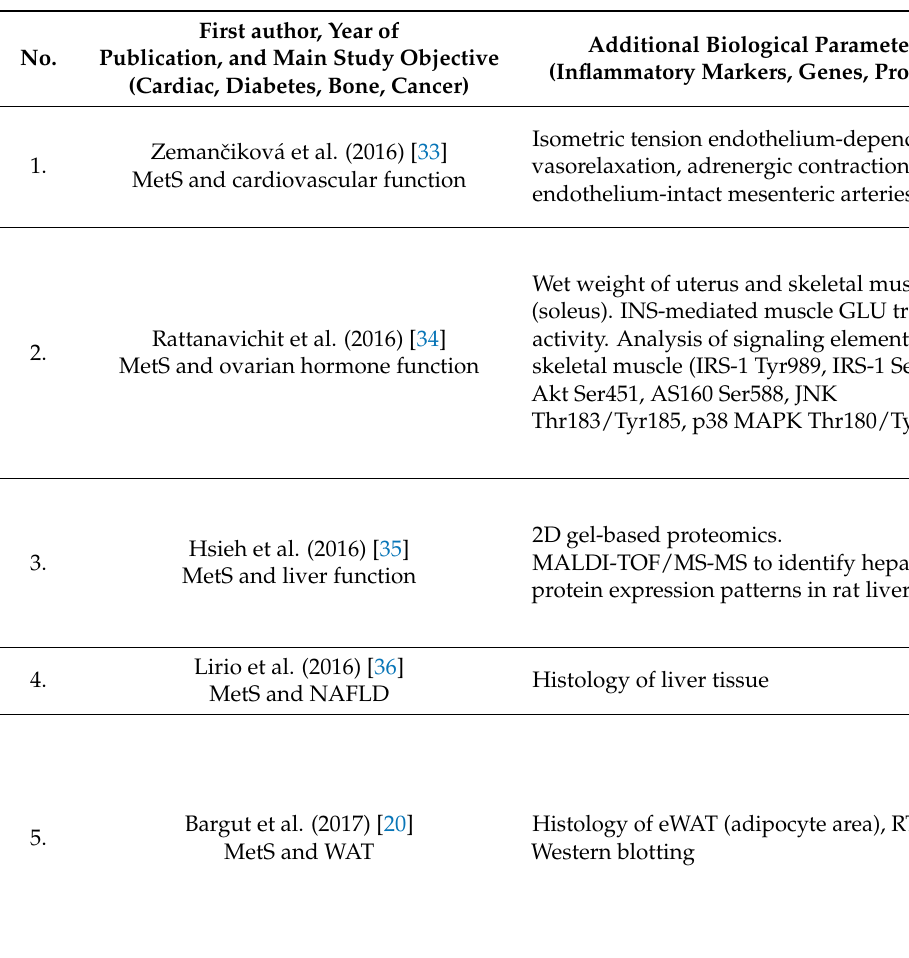
Table 2. Additional biological parameters, methodology, and outcomes of MetS and related